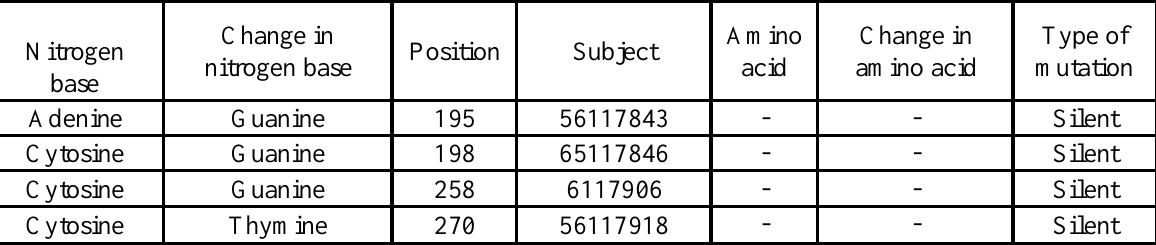
Table (1): Changes in Nitrogenous Bases and Their Effect on Translating Amino Acid of the QacE gene for Ps-2 Isolate of P.